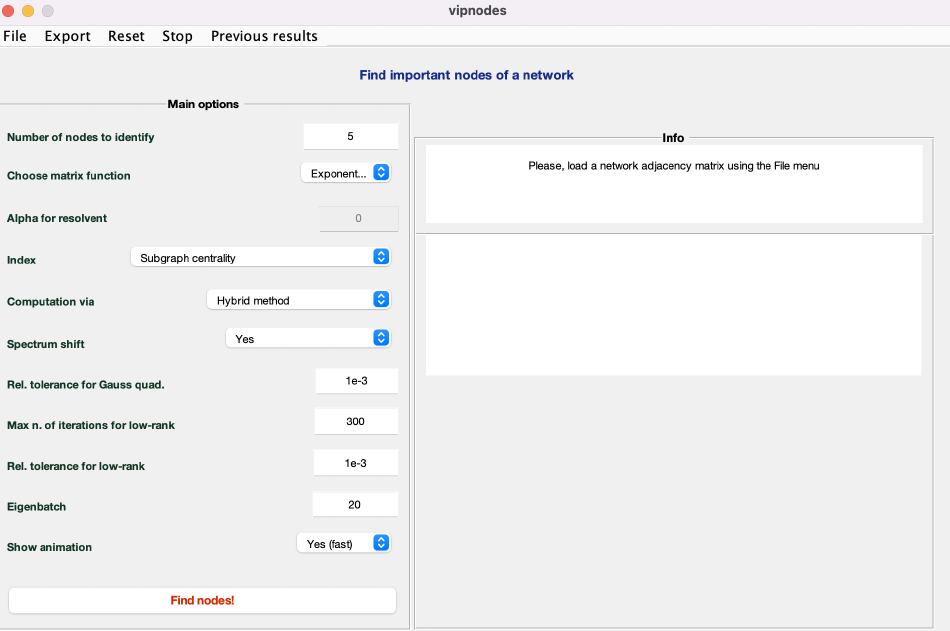
Figure 1. The graphical user interface